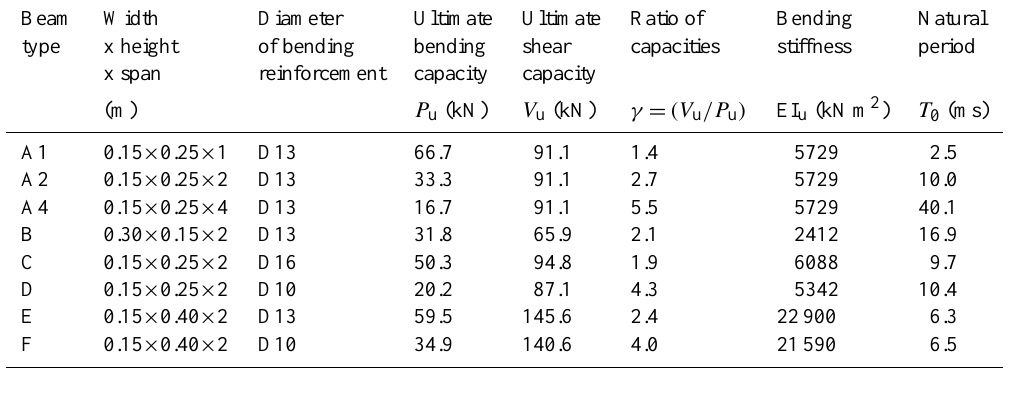
Wire for lift up Impact weight